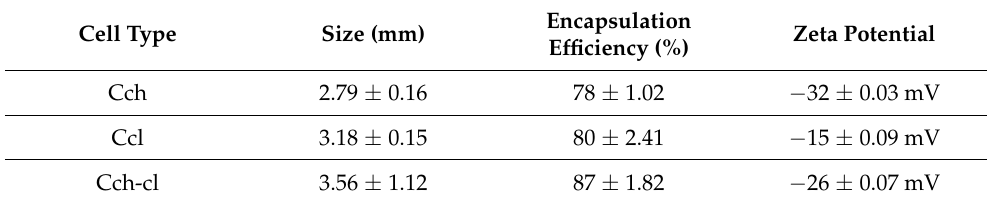
Table 1. Size, encapsulation efficiency, and zeta potential of encapsulated cells.